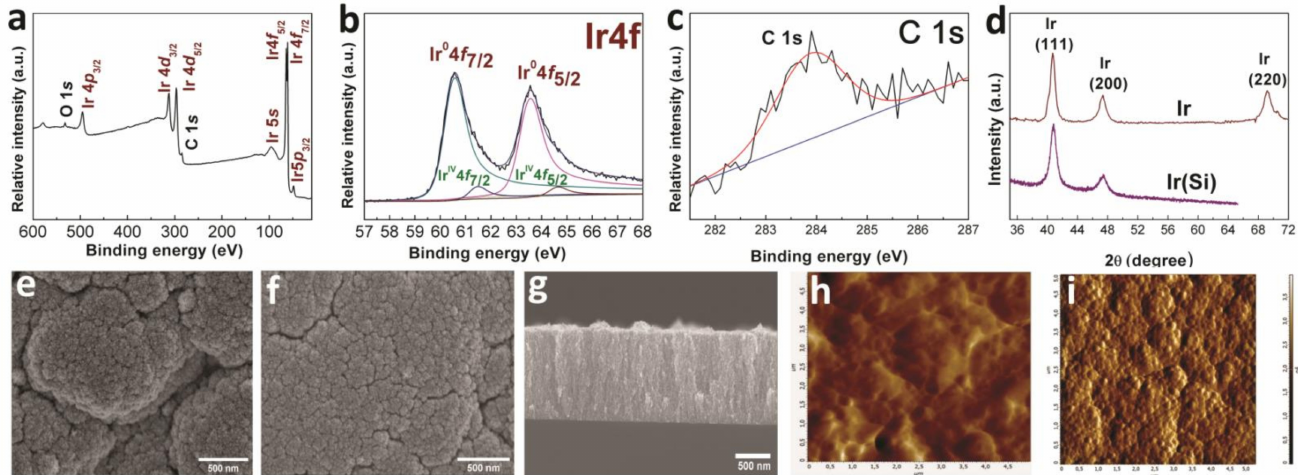
Figure 1. XPS spectra of Ir(Si) sample after etching with Ar + ( a ), fitting of Ir 4 f spectra ( b ), and fitting of C1 s spectra ( c ); XRD patterns of Ir and Ir(Si) samples ( d ); SEM micrographs of the sample surface (Ir ( e ) and Ir(Si) ( f )) and cross-section of Ir(Si) sample ( g ); AFM micrographs of Ti-alloy without ( h ) and with Ir coating ( i